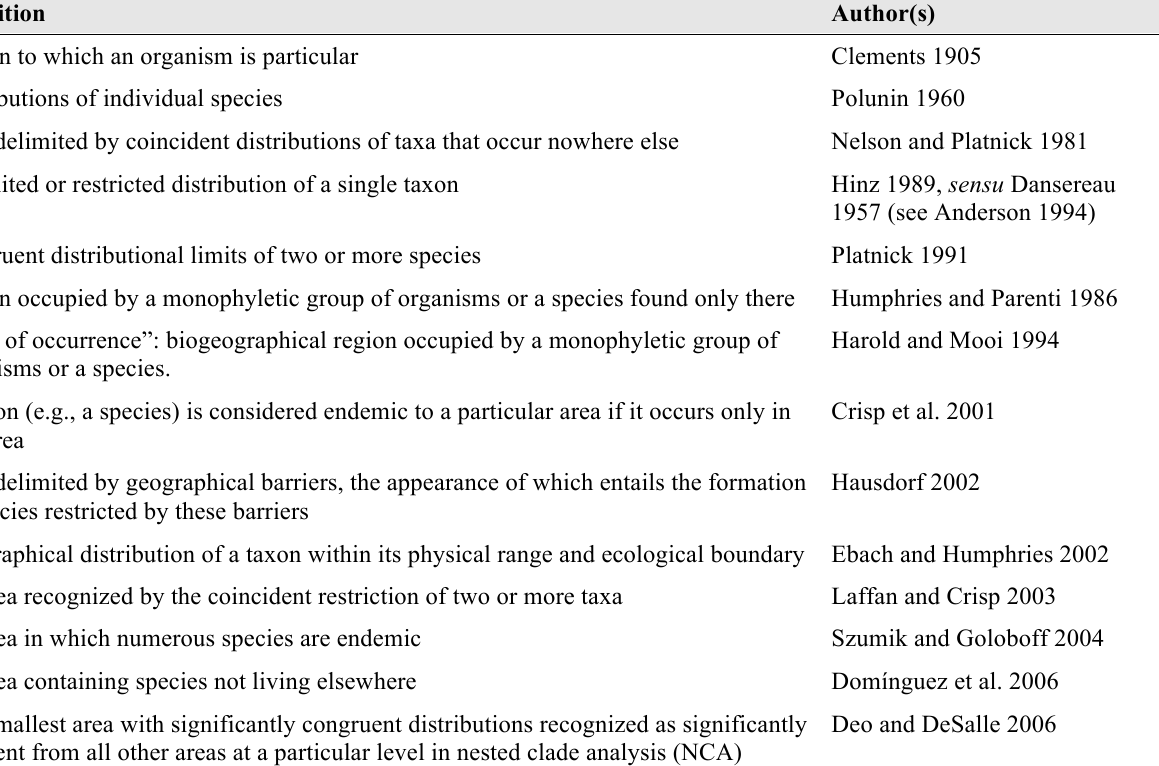
Table 1. Definitions of endemic area (modified from Parenti and Ebach 2009)